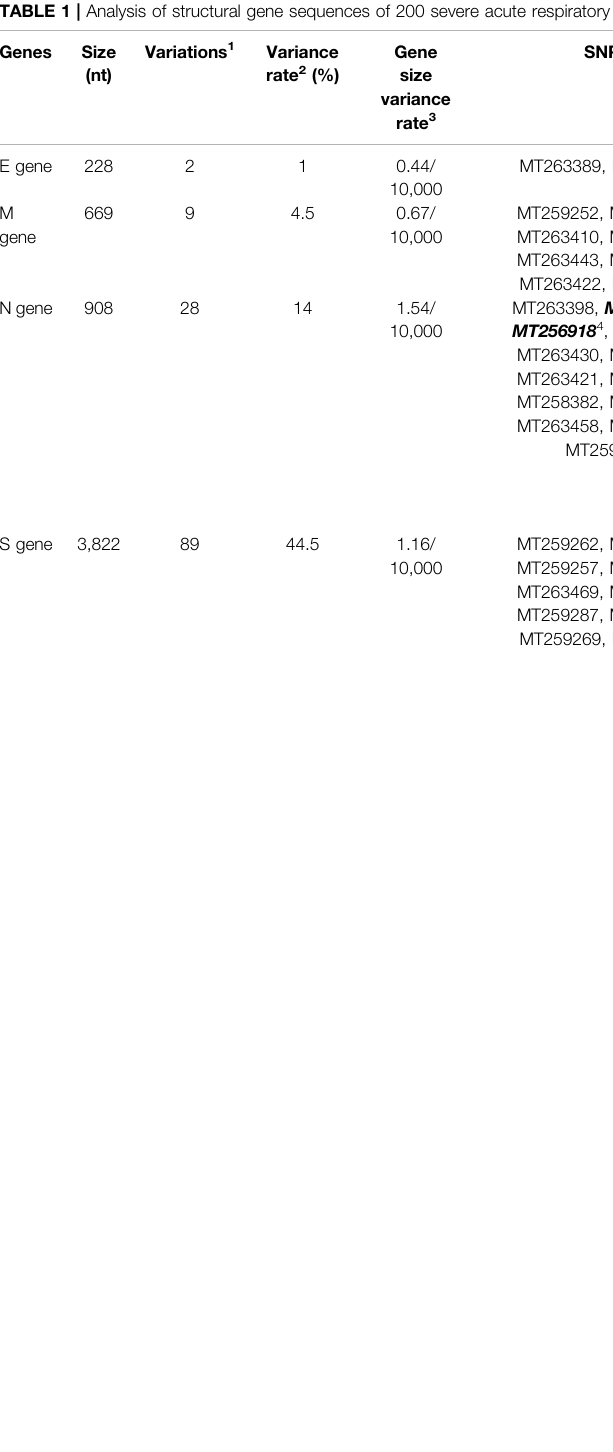
TABLE 1 | Analysis of structural gene sequences of 200 severe acute respiratory syndrome coronavirus-2 (SARS-CoV-2)